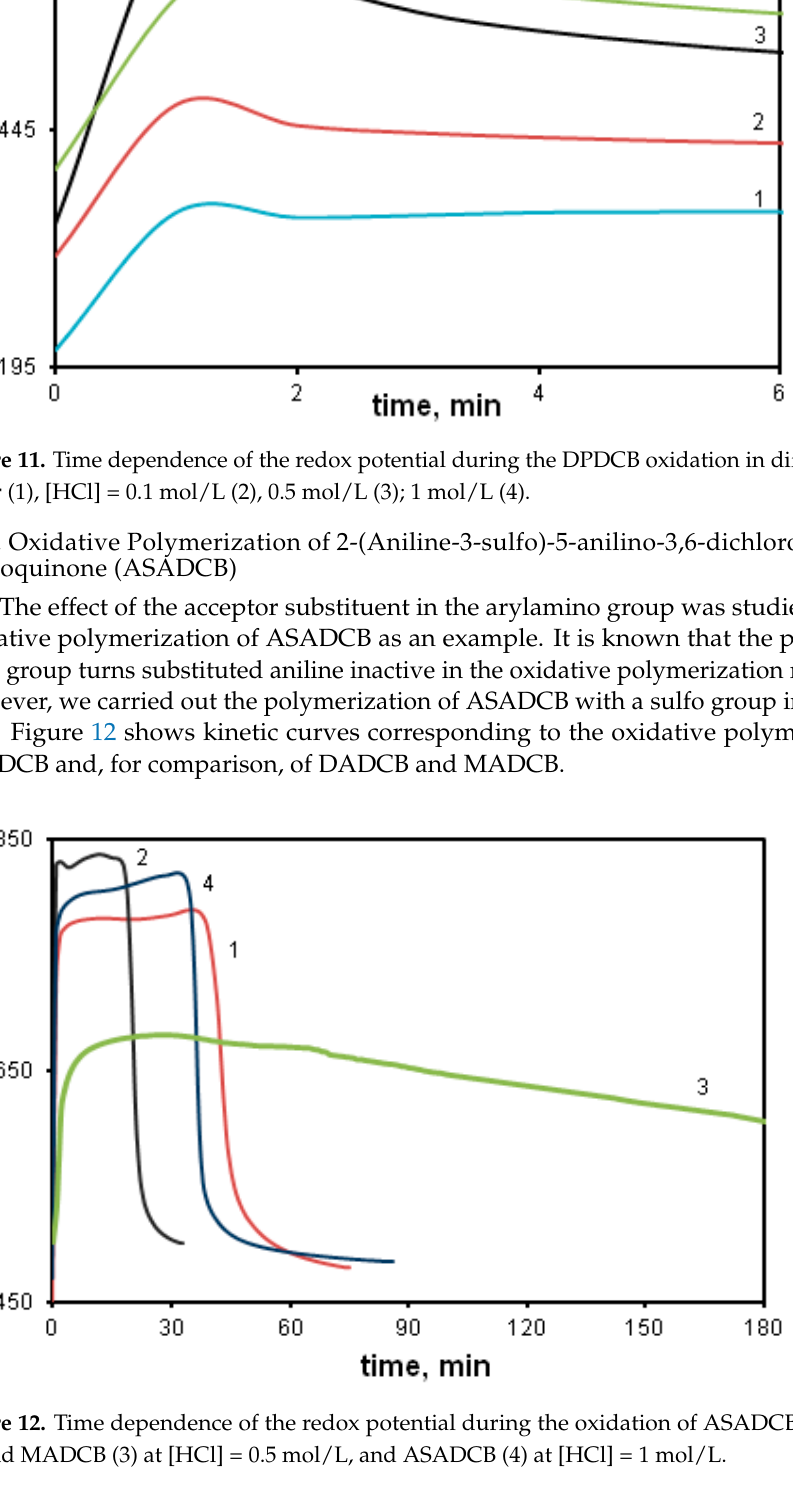
Figure 10. Time dependence of the redox potential during the DPDCB oxidation at different ratios of [Ox]/[DPDCB]: 0.5 (1), 0.75 (2), 1.25 (3), 3.75 (4).